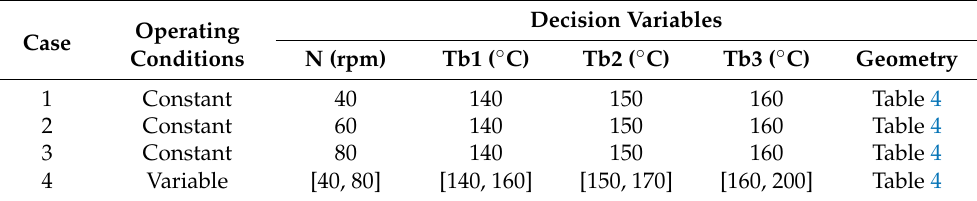
Table 3. Cases studied for LDPE—only in case 7 the operating are used as decision variables.